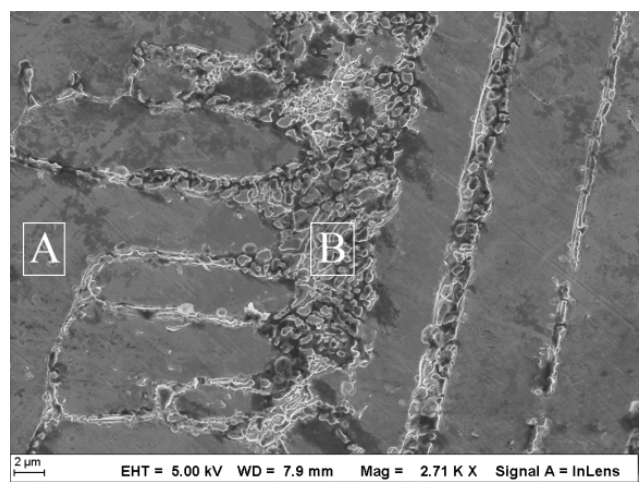
Figure 9. SEM image of cross-section morphology of Sample 5 coating.